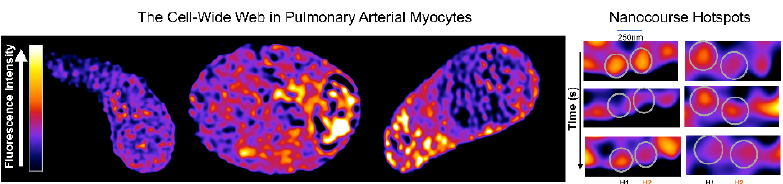
Figure 13. From left to right, panels show pseudocolour representations of deconvolved z sections of Fluo-4 fluorescence that identify a cell-wide network of cytoplasmic nanocourses within three different acutely isolated pulmonary arterial myocytes, irrespective of cell size or shape. Right hand panels show enlarged images of two cytoplasmic nanocourses from the same cell, in which asynchronous, time-dependent fluctuations in hotspots of calcium flux (from top to bottom) can be seen.